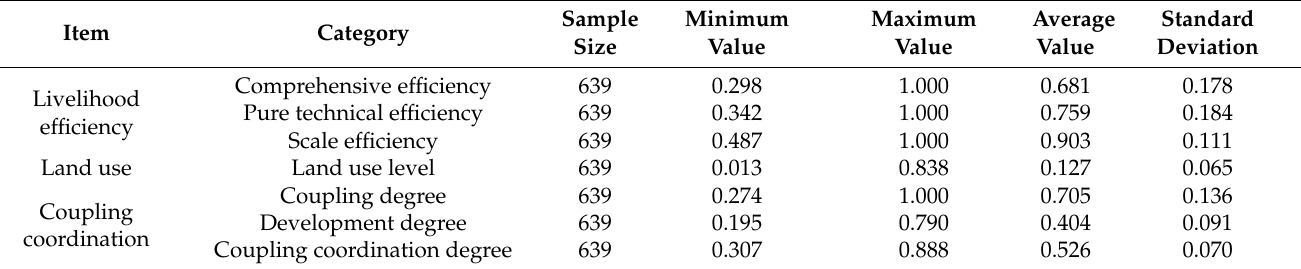
Table 5. Statistics for coupling coordination between household livelihood efficiency and land